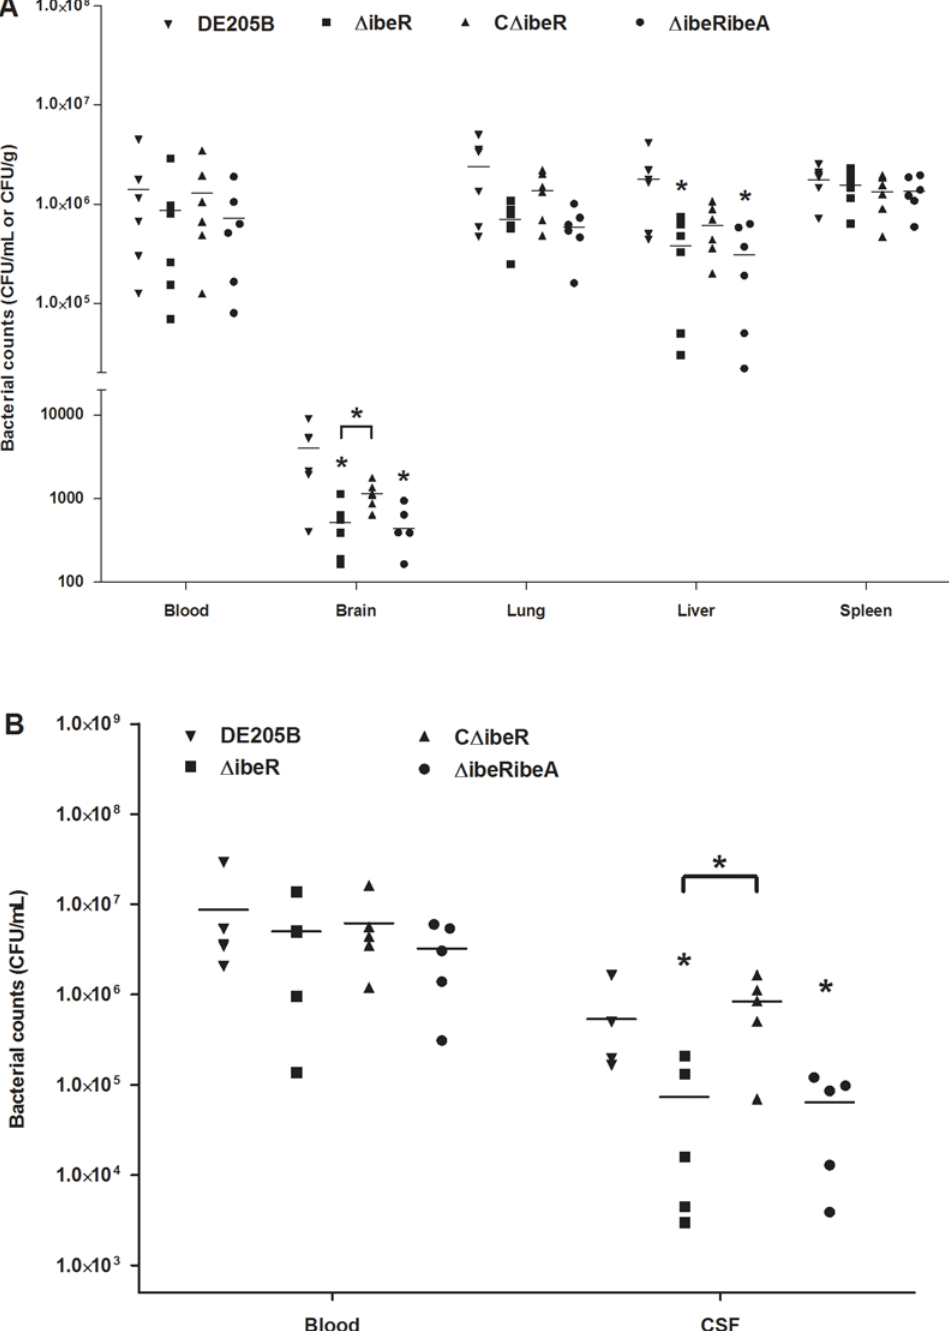
Fig 5. Animal infection experiments. (A) Bacterial enumeration during animal systemic infection. Groups of six 8-week-old ICR mice were infected intraperitoneally with a sublethal dose bacterial suspension of 2.0 × 10 6 CFUs. Bacteria were recovered from blood, brains, lungs, liver and spleen at 24 h post infection. (B) Bacterial enumeration in rat neonatal meningitis model. At 5 days of age, groups of five SPF Sprague-Dawley rat pups were inoculated intraperitoneally with a bacterial suspension containing 10 7 CFUs. At 18 h after bacterial inoculation, blood and cerebrospinal fluid (CSF) specimens were obtained for quantitative cultures. Nonparametric Mann-Whitney U-Test was carried out for statistical significance analysis. * p < 0.05.